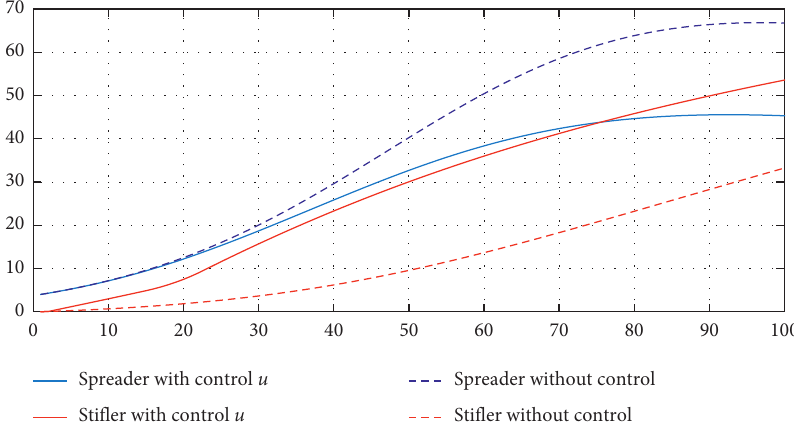
Figure 4: Dynamics with controls u .